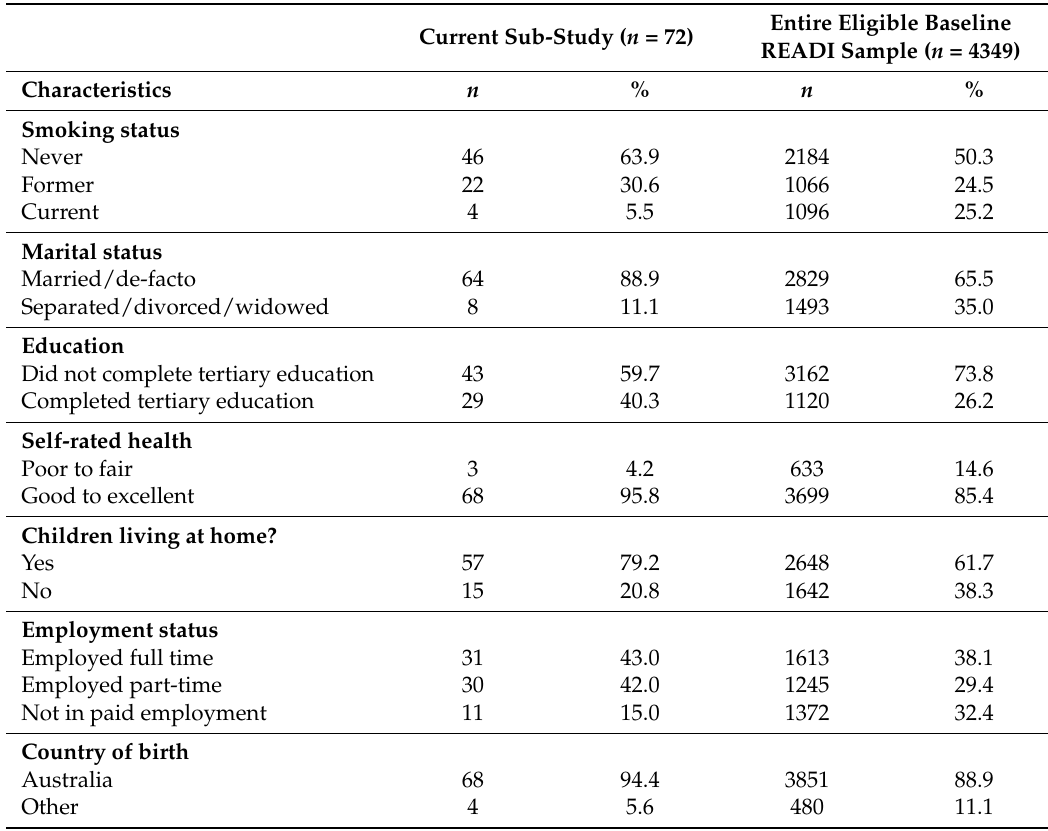
Table 1. Sociodemographic characteristics of women ( n =